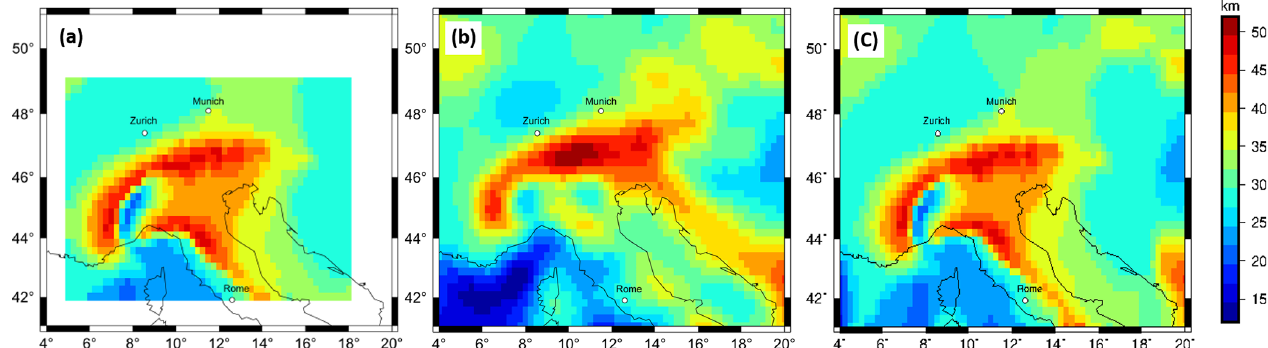
Figure 2. (a) Digitized Moho depth after Spada et al. (2013) with a 0.25 ◦ grid spacing. (b) Moho depth estimation after Grad et al. (2009) with a 0.25 ◦ grid spacing (c) merged Moho depth map from Spada et al. (2016) and Grad et al. (2009) with a grid resolution of 0.25 ◦ using a cosine taper with a 2 ◦